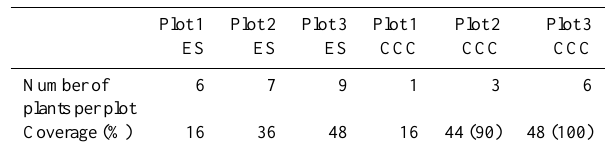
Table 2. Number of L. corniculatus (L) plants and coverage (%) per plot (50 × 50cm) at the experimental site (ES) and Chicken Creek Catchment (CCC) for low (plot 1), intermediate (plot 2) and high (plot 3) vegetation density. For the coverage of plot 2 and plot 3 on the CCC numbers in brackets refer to the coverage of L. cornicula- tus plus the co-occurring grass